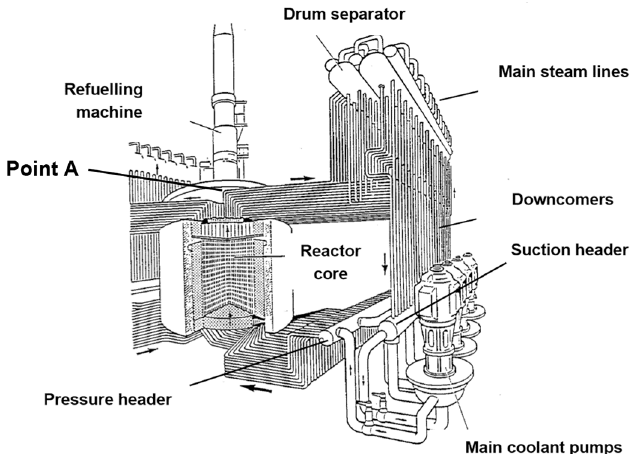
Fig. 16. Cooling system of the